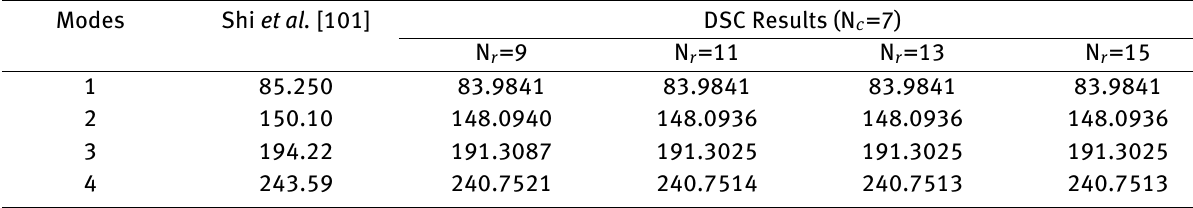
Table 1: Comparison of frequencies ( Ω = ωR 2 2 √︀ ρh / D ) of annular sector plates ( υ =0.33; α =60 0 ; R 1 /R 2 =0.4 ) with CCCC edge conditions